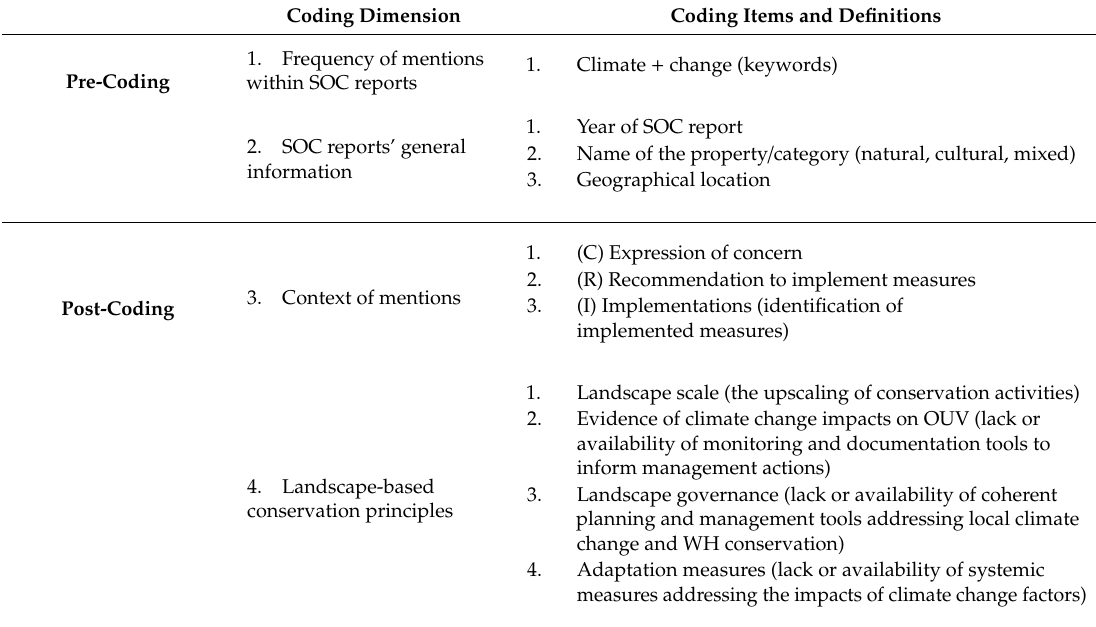
Table 1. Coding dimensions and